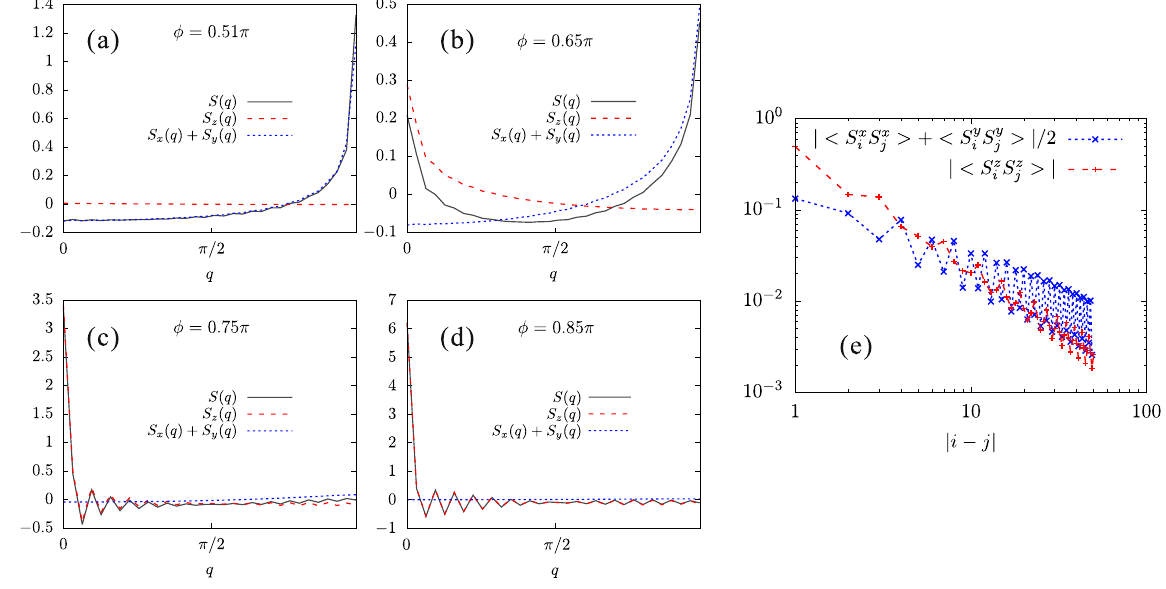
Figure 5. Static spin structure factors for ( a ) φ = 0.51 π , ( b ) φ = 0.6 π , ( c ) φ = 0.65 π , and ( d ) φ = 0.75 π . ( e ) Log- log plot of the spin-spin correlation functions as a function of distance at φ = 0.6 π